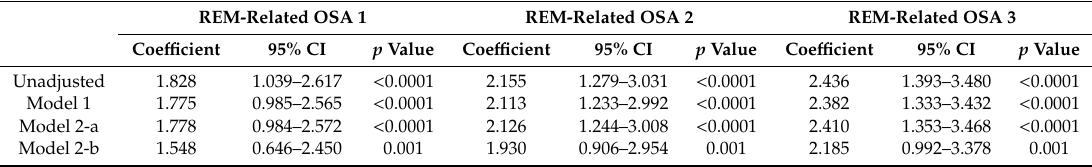
Table 4. Association between three di ff erent definitions of REM-related OSA and the Pittsburgh Sleep Quality Index score in female